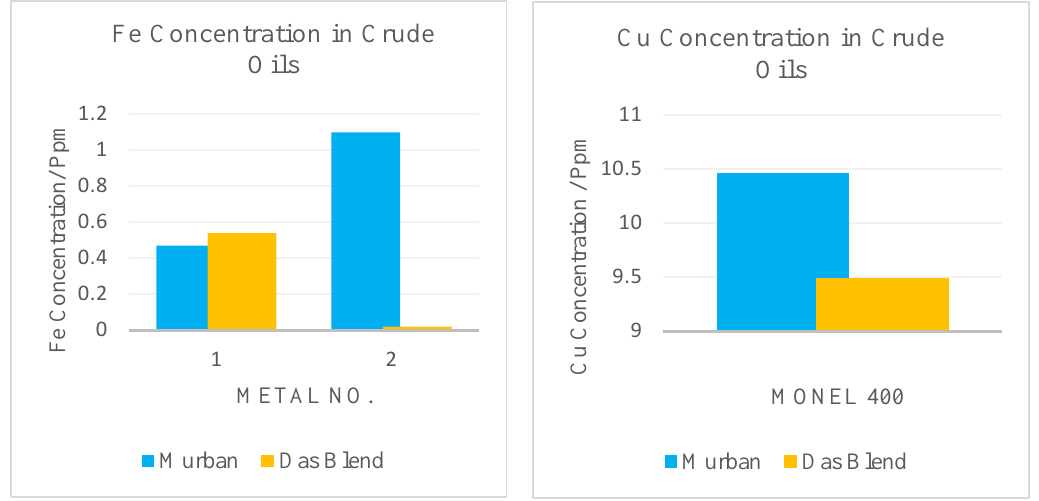
Figure 3. The elemental concentrations of Fe and Cu with respect to the crude oil